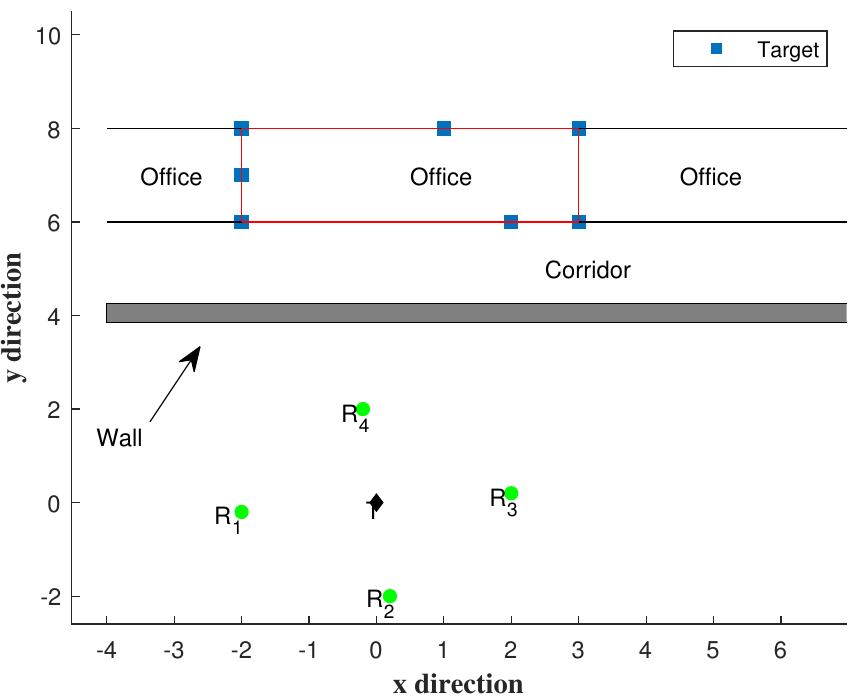
Figure 1. Location map showing target location and transmitter and receiver locations, for a scenario with a 10 m 2 office and a corridor in